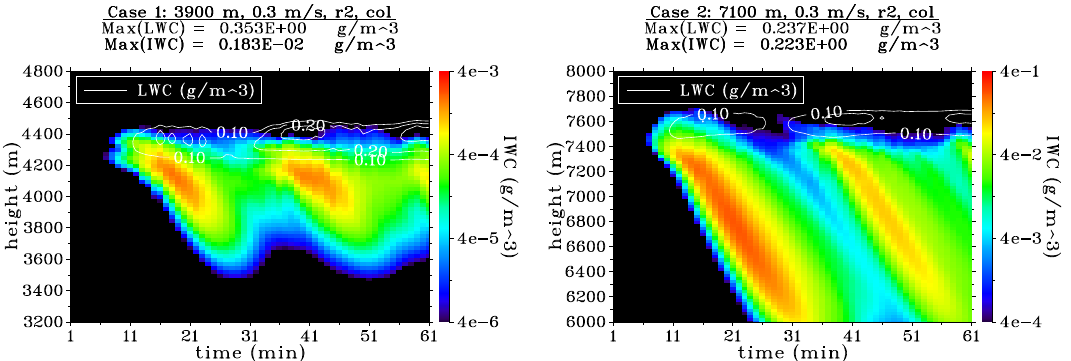
Figure 20. LWC (contours) and IWC (colors, logarithmic scale). Results for changing ice particle shape to hexagonal columns for case 1 (W_col, left) and case 2 (C_col, right).